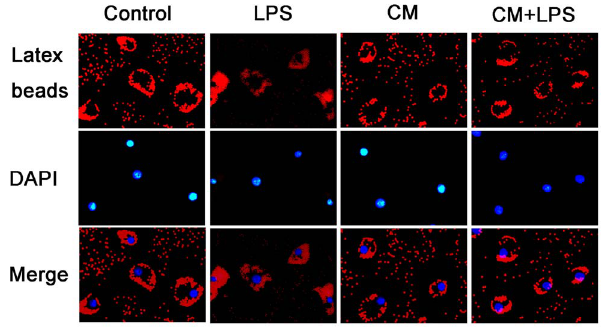
Figure 3. BMSCs inhibit phagocytosis by microglial cells. We tested the capacity of microglia to phagocytose fluorescent-labeled latex beads by observing them under a fluorescence microscope (magnification 400 6 ). The microglial cells were incubated in DMEM/F- 12 or conditioned medium with or without LPS (1 m g/mL) at 37 u C in 5% CO2 in air and 95% humidity. The nuclei were counterstained with DAPI. Following incubation with LPS (1 m g/mL) for 4 hours, microglia clearly ingested more latex beads than untreated control groups, while the phagocytic activity of microglia in the conditioned medium (CM) treated-groups was significantly inhibited.